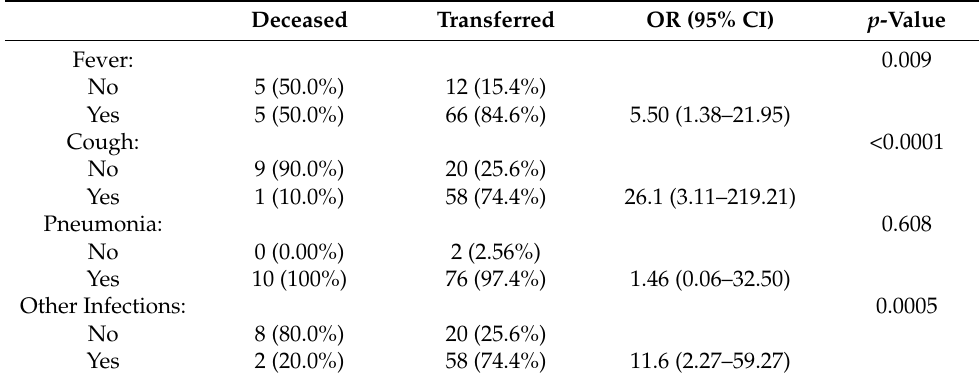
Table 2. Clinical data of deceased and transferred COVID-19 ICU